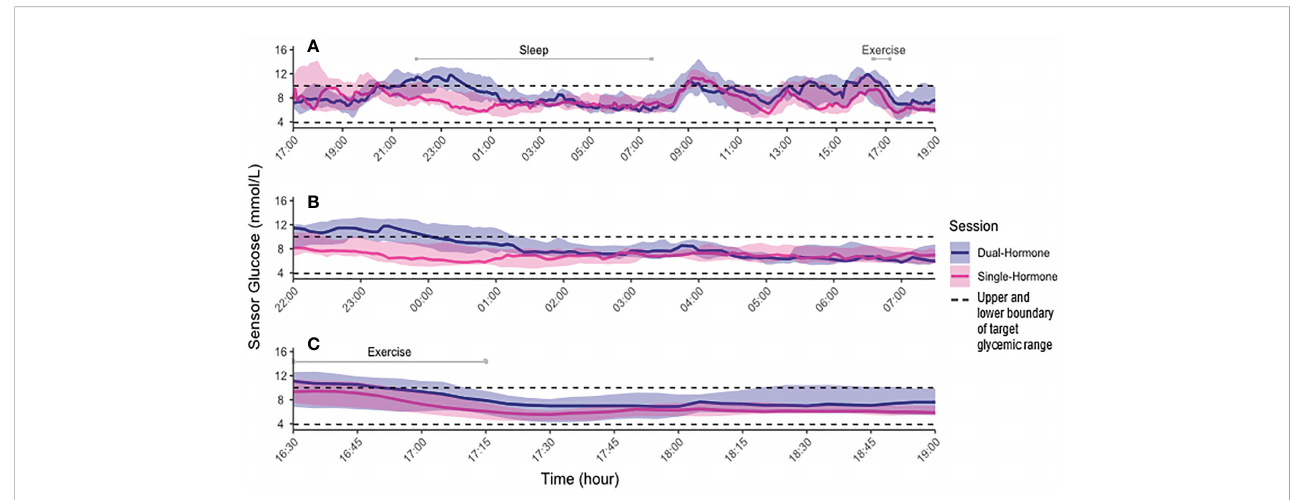
FIGURE 3 Median (interquartile range) sensor glucose values for Dual-hormone (blue) and Single-Hormone (pink) con fi guration. (A) Entire period. (B) Overnight period (10:00 pm-7:30 am). (C) Exercise and post-exercise period. Black dotted lines mark lower and upper boundary of target glycemic range of 3.9 to 10.0 mmol/L, respectively.